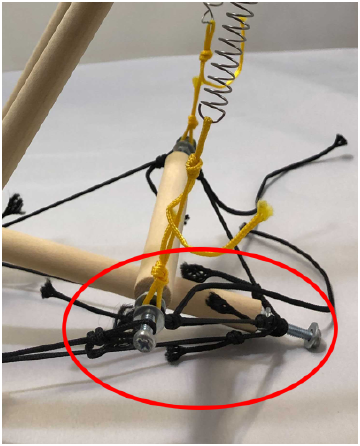
Figure 9. Joints between compression and tensile materials. The tensile member indicated by the red circle is No. 12.